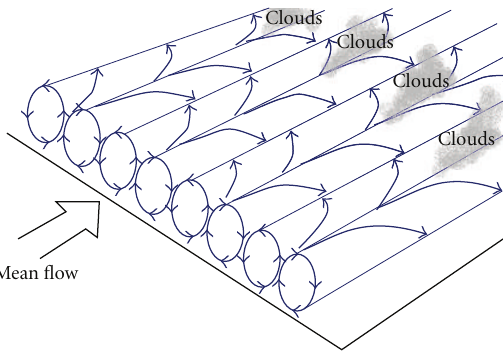
Figure 7: Illustration of the role of horizontal vortices in the development of cloud streets (based on Etling and Brown